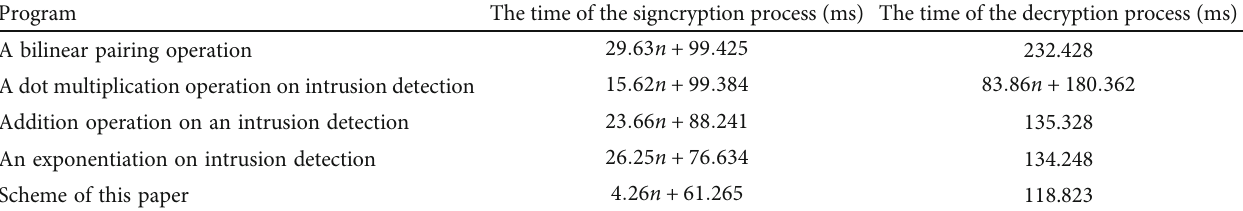
Table 1: Comparison of this scheme with other schemes.